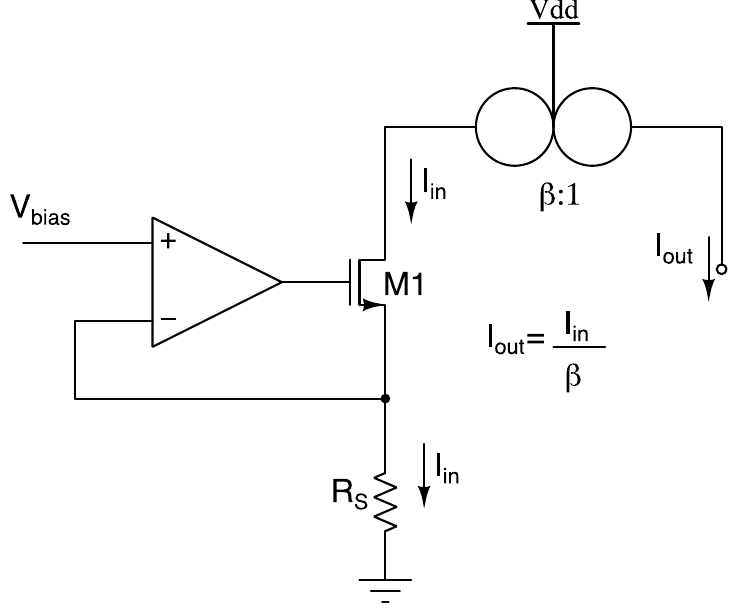
Figure 2. R-I converter.